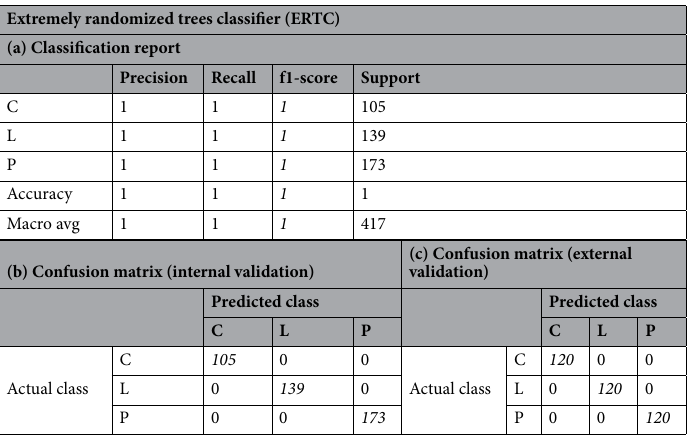
Table 2. (a) Classification report, (b) confusion matrix for internal validation, and (c) confusion matrix for external validation resulting from the ERTC